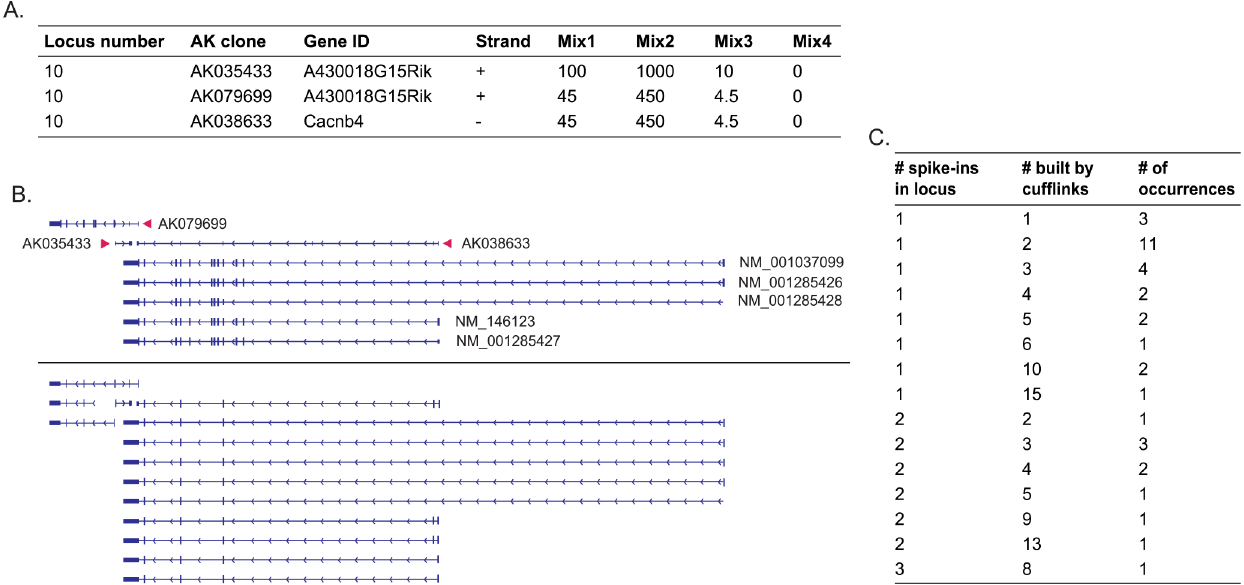
Fig 7. Cufflinks assembly of transcripts (A) Information regarding the spike-ins used for locus 10. The concentration of the spike-ins in each mix is shown (attomoles/ μ l). (B) The RefSeq+ and Cufflinks assembled transcripts structure within locus 10. (C) Table showing the number of transcripts spiked-in and the number of transcripts reported in the Cufflinks assembly